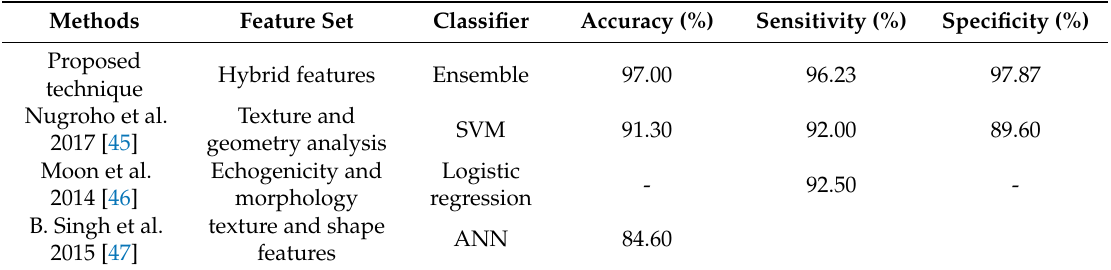
Table 8. Comparison with other